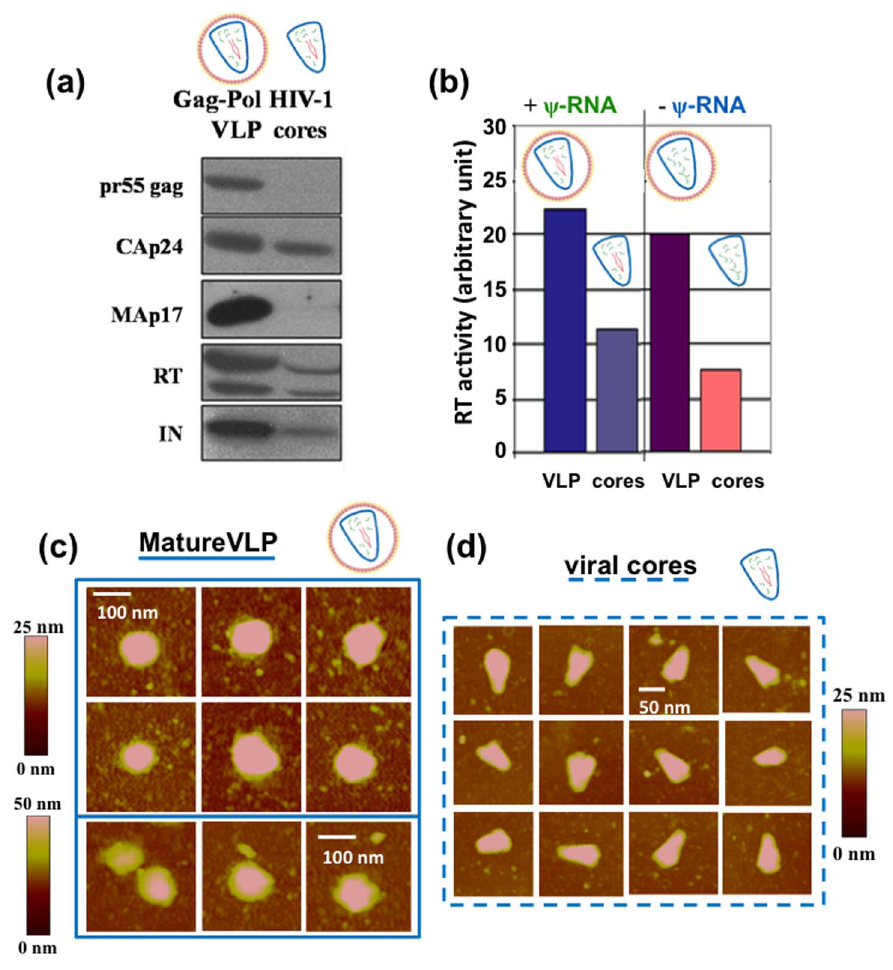
Figure 1. Biochemical characterization of VLPs and viral cores, and AFM imaging. (a) Immunoblot of HIV-1 for mature and immature VLPs and cores. (b) Reverse transcription test on mature VLPs and cores in the presence or the absence of y RNA in the VLPs or cores. (c) Typical images of mature VLPs. (d) Typical images of viral cores.